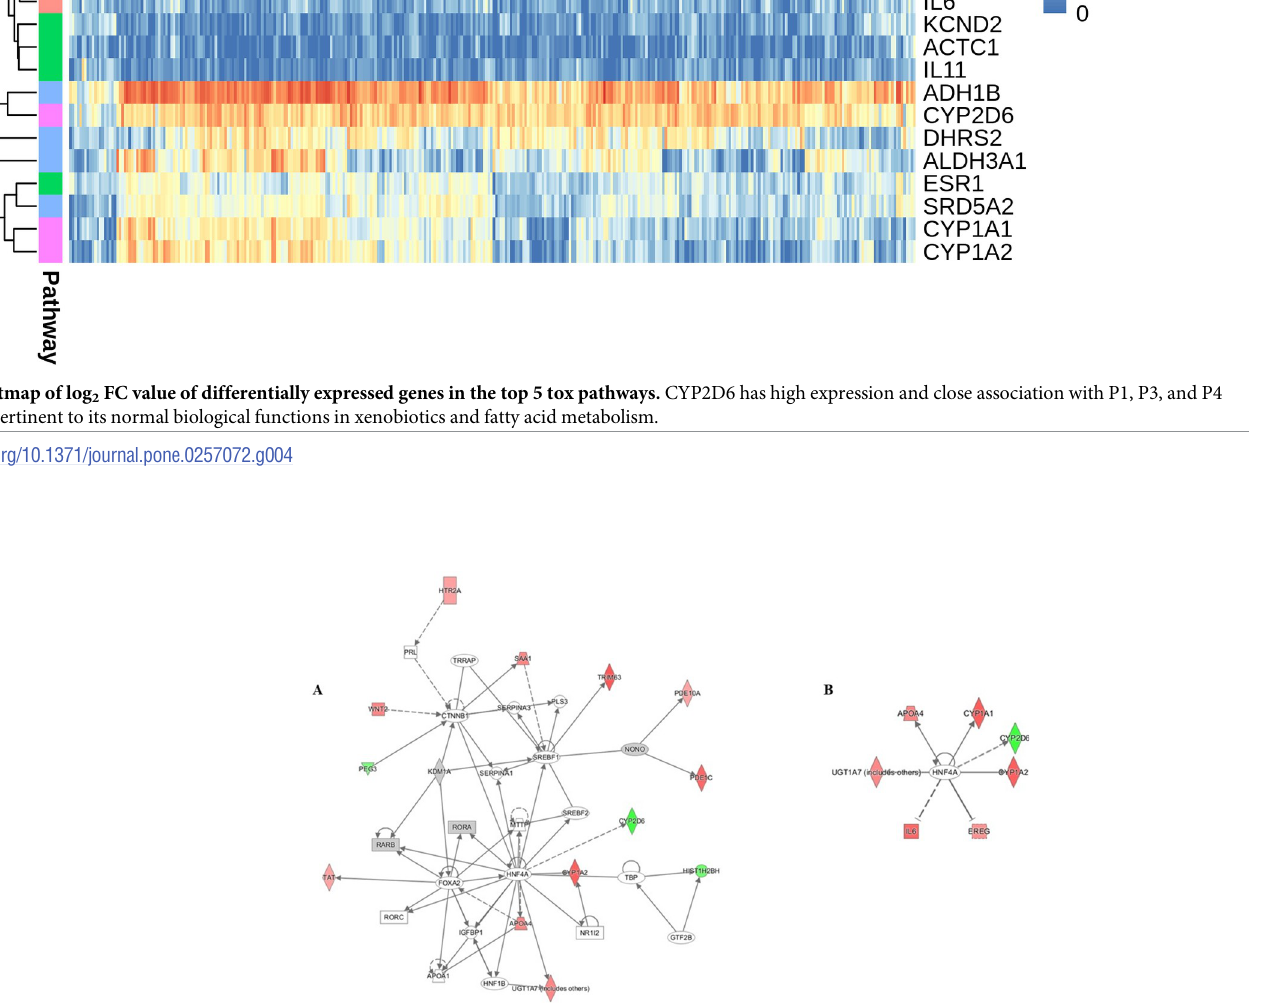
Fig 5. IPA analysis of differentially expressed genes. (A) Network analysis reveals a direct interaction between CYP2D6 and HNF4A. (B) Upstream network analysis of HNF4A shows CYP2D6 and IL6 as major players.